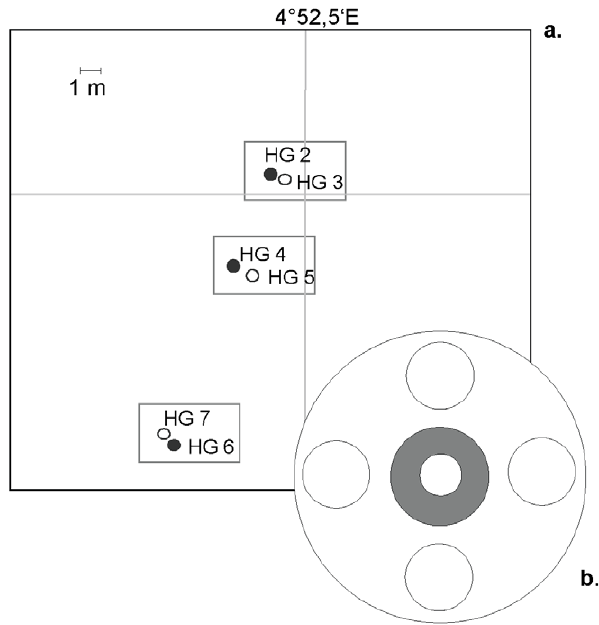
Figure 3. Close-up of the sampling site and sub-sampling of the sediment cores. (a.) Positions of the control cores (HG3, HG5, and HG7, open circles), and sponge cores (HG2, HG4, and HG6, closed circles). (b) Sub-sampling scheme of the sponge cores. Sub-sampling of the control cores corresponds to the sub-sampling scheme of the sponge